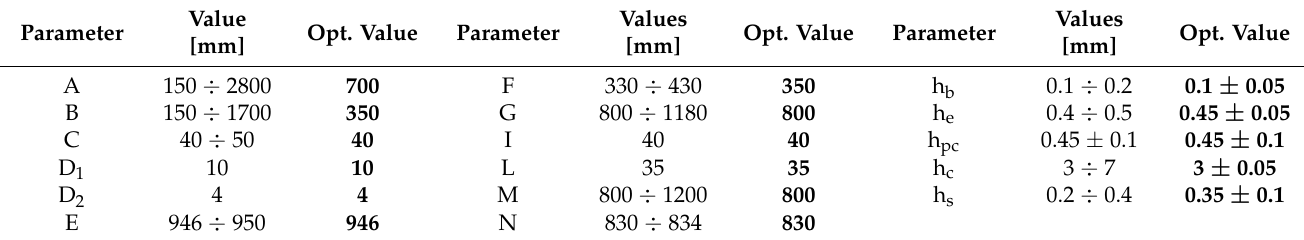
Figure 14. Overall dimensional parameters in FE model. Table 8. PV panel dimensional parameters.